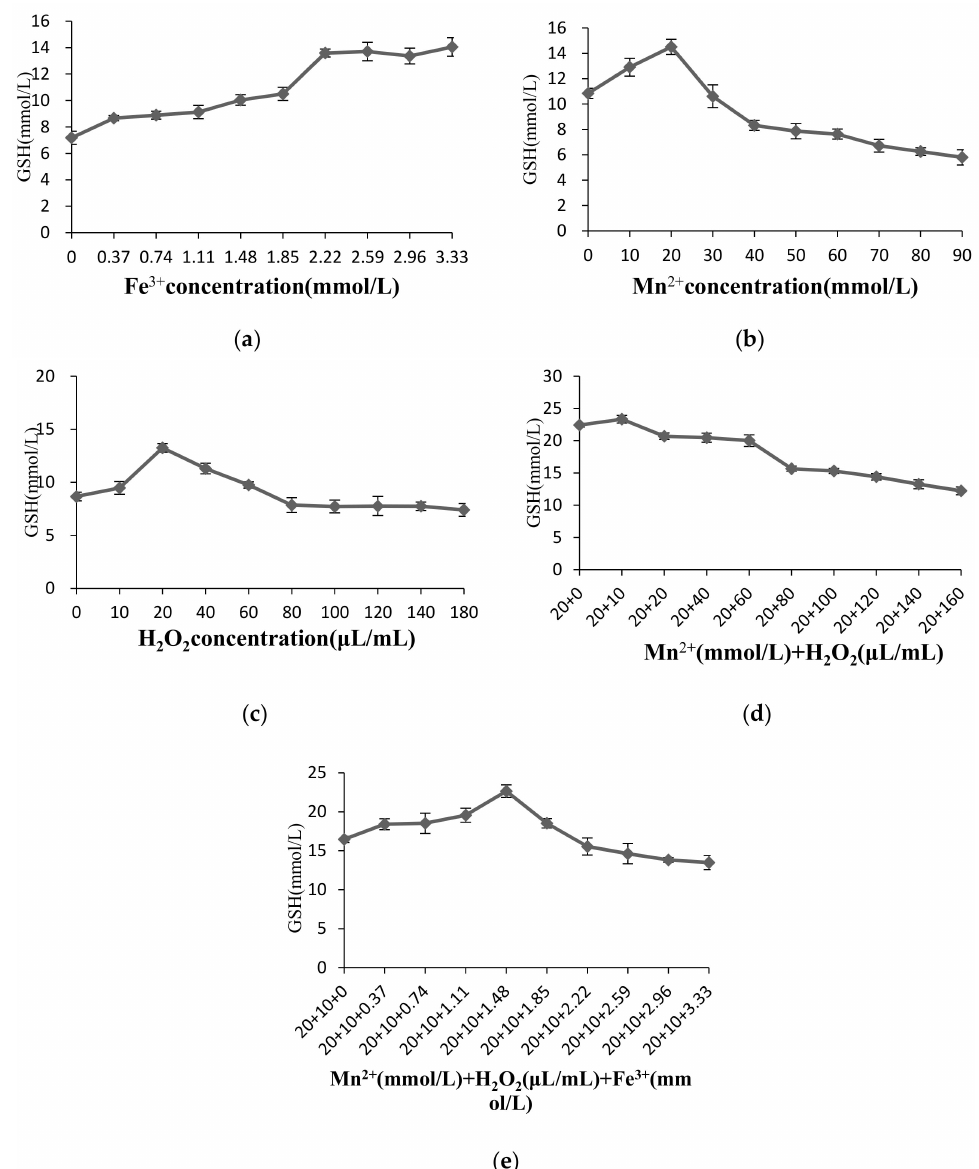
Figure 4. The e ff ect of oxidative stress environment on glutathione synthesis (in the 100 mL reaction system). ( a ) the e ff ect of di ff erent Mn 2 + concentrations, 0 mmol / L (control)–90 mmol / L; ( b ) the e ff ect of di ff erent H 2 O 2 concentrations, 0 µ L / mL (control)–180 µ L / mL; ( c ) the e ff ect of di ff erent Fe 3 + concentrations, 0 mmol / L (control)–3.33 mmol / L; ( d ) the e ff ect of Mn 2 + (20 mmol / L) combined with H 2 O 2 at di ff erent concentrations, 0 µ L / mL (control)–160 µ L / mL; ( e ) the e ff ect of Mn 2 + (20 mmol / L) and H 2 O 2 (10 µ L / mL) combined with Fe 3 + at di ff erent concentrations, 0 mmol / L (control)–3.33 mmol /